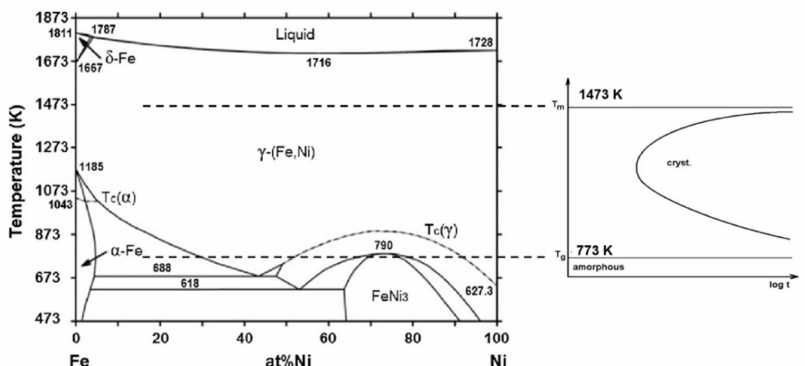
Figure 17. Equilibrium phase diagram of the Fe-Ni system together with the expected cluster formation in the supercooled melt, and a schematic TTT diagram for crystal growth from the supercooled FeNiSiB melt. The temperature range of the Tg line is approximately 773 K in this alloy. Adopted from [89], with permission from Elsevier,